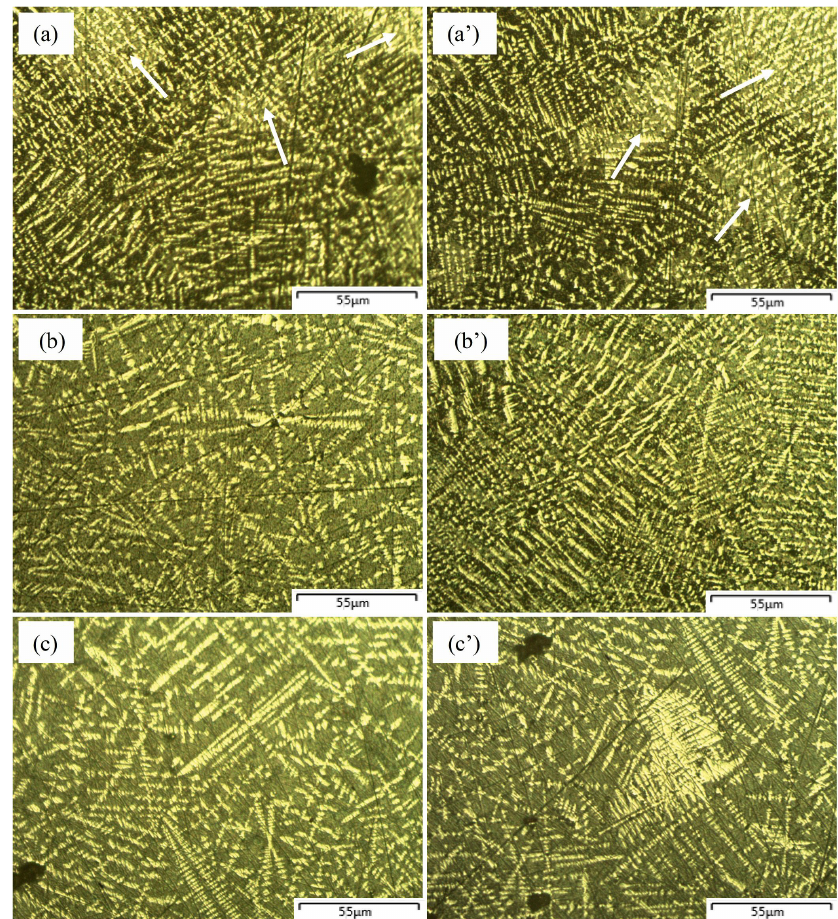
Figure 6. Optical microscopies of glass-ceramics obtained from Ca Glass treated at 960 ºC during (a), (a ‘) 2 hs, (b), (b’), 4 hs and (c), (c ‘) 6 hs. Samples treated in HF